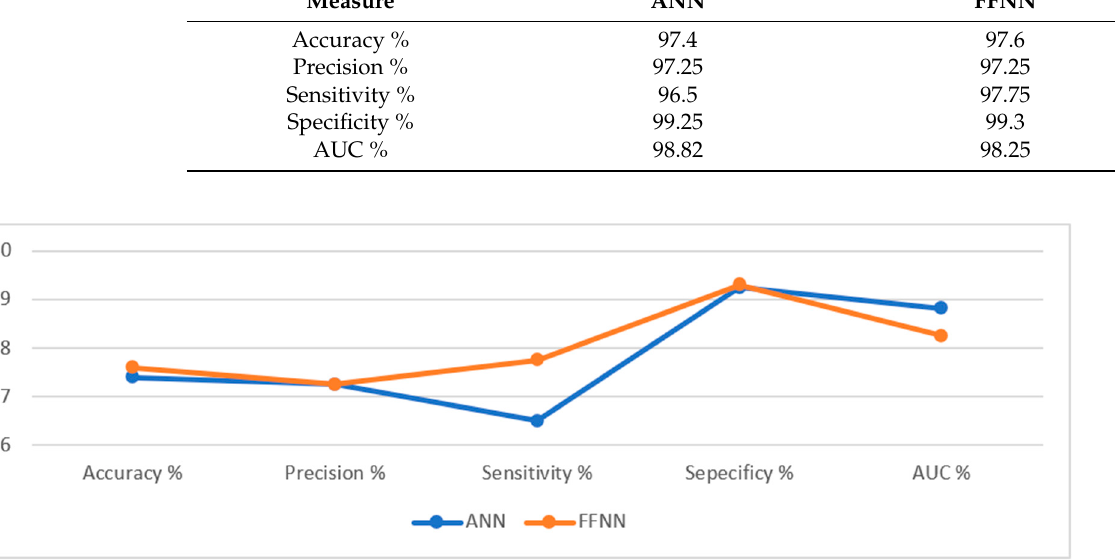
Table 3. Data augmentation method during the training phase.